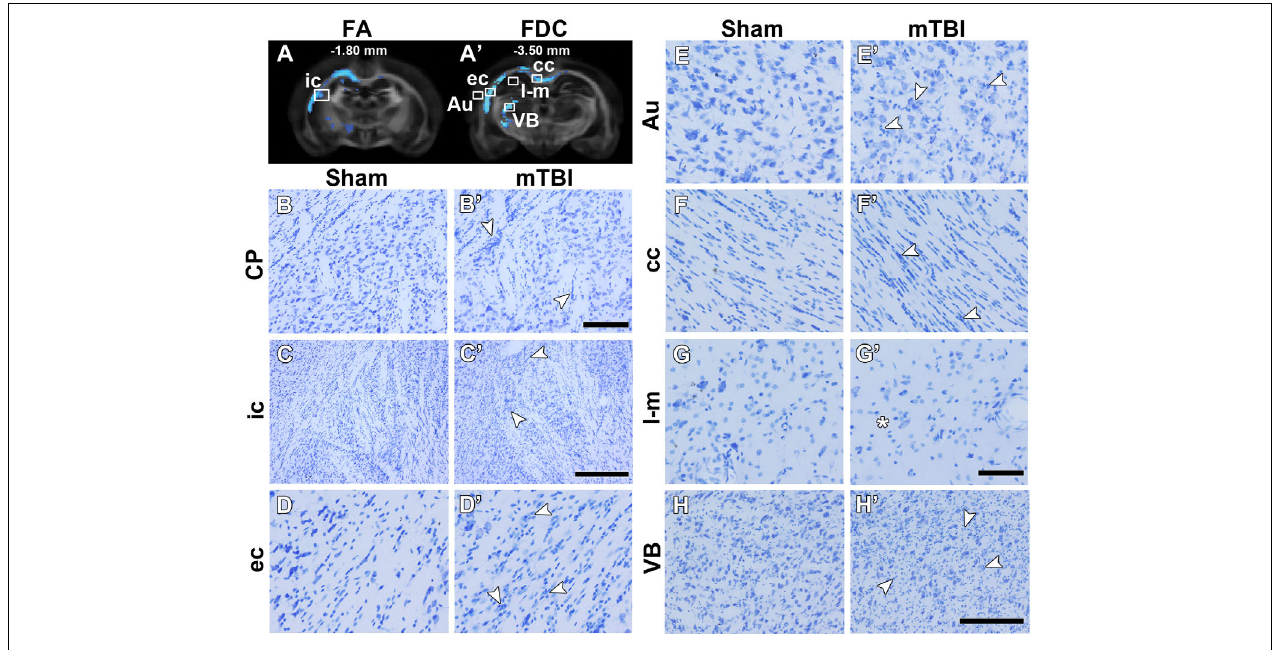
FIGURE 3 | FA (A) and FDC (A’) at –1.80 and –3.50 mm from bregma, respectively, from the group analyses. White squares indicate the location of the photomicrographs shown in (B–H) . Representative photomicrographs of Nissl-stained sections of a sham-operated and a mTBI rat from the caudate putamen (B,B’) from –0.90 mm (not shown in A ), internal capsule (C,C’) from –1.80 mm, and external capsule (D,D’) , auditory cortex (E,E’) , corpus callosum (F,F’) , stratum-lacunosum moleculare (G,G’) , and ventrobasal complex (H,H’) from –3.50 mm from bregma. White arrowheads point at gliosis alterations associated with axonal damage and asterisk indicates less cell density. CD values of these two animals shown in this figure are shown in Supplementary Table 1 . Au, auditory cortex; cc, corpus callosum; CP, caudate putamen; ec, external capsule; ic, internal capsule; l-m, stratum-lacunosum moleculare; VB, ventrobasal complex. Scale bars: 50 µ m (B,B’,D,D’–G,G’) , 150 µ m (H,H’) , and 250 µ m (C,C’)